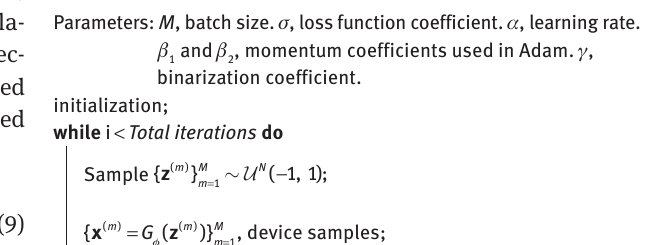
Algorithm 1: Generative neural network-based